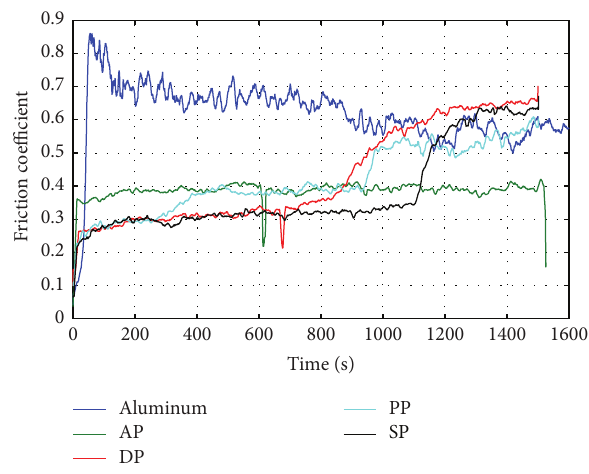
Figure 3: Friction coefficient of the studied primers/topcoat applied on the aluminum substrate as a function of sliding